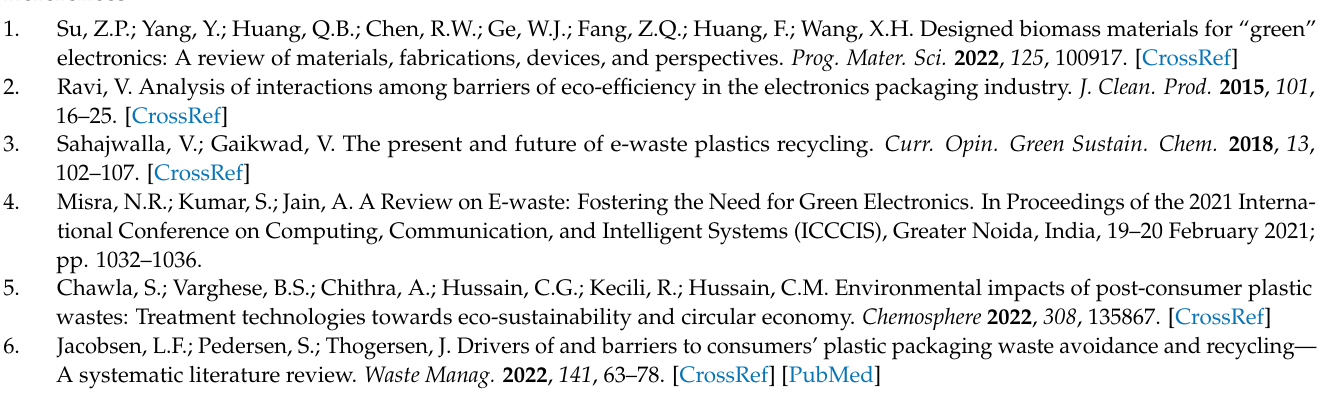
Figure S2: Approximation fits for electrical percolation threshold of GN and NCB DC conductivity, Figure S3: Thermal conductivity values at (a) 308.15 K (b) 318.15 K, Figure S4: Arrhenius plots of thermal conductivity dependence on temperature for (a) NCB (b) CB, Figure S5: NCB microwave dielectric spectroscopy (a) real part of permittivity (b) imaginary part of permittivity, Figure S6: Time domain spectroscopy transmittance spectra of composites (a) NCB (b)